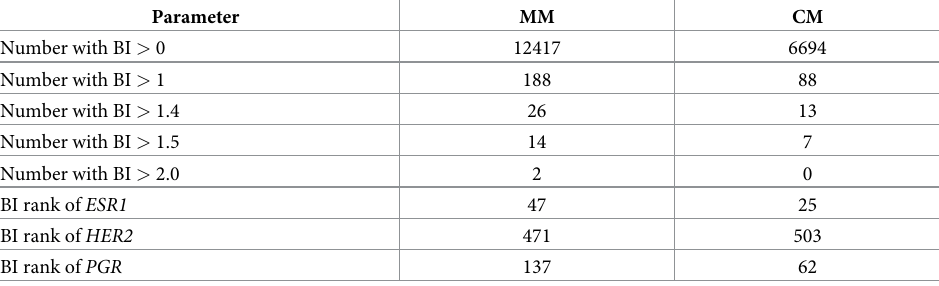
Table 1. Methodology performance. Methods were tested on breast cancer RNA-seq data and compared with regards to the number of genes identified at various bimodality index (BI) thresholds and ranking of known bimodally expressed genes ( ESR1 , HER2 , and PGR ). CM: controlled mixture modeling, MM: mixture modeling.